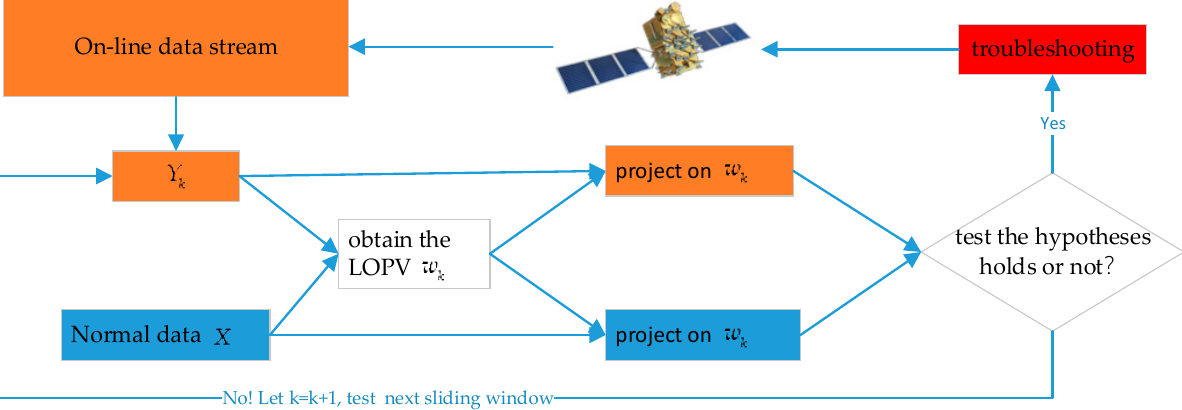
Y . Figure 2. The idea of hypothesis testing to detect incipient faults for each Y k k